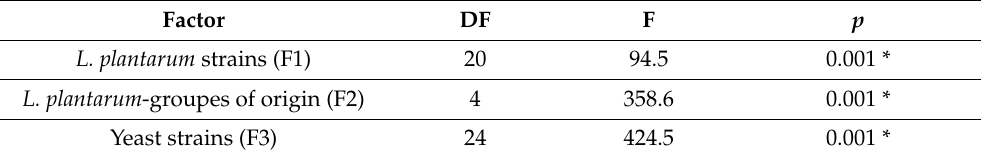
Figure 2. The numbers of yeast strains (25) showing no inhibition, total inhibition (6–7), and partial inhibition (2–5) by L. plantarum strains (20) based on index scale values from the overlay method (Table 3) on artificial media. Table 7. The interactions between lactobacilli and yeast strains in the in vitro overlay method, including two control variants for each yeast strain. ANOVA, Statistica Software v. 12, Post Hoc Tukey’s HSD Test, * Significant at α ≤